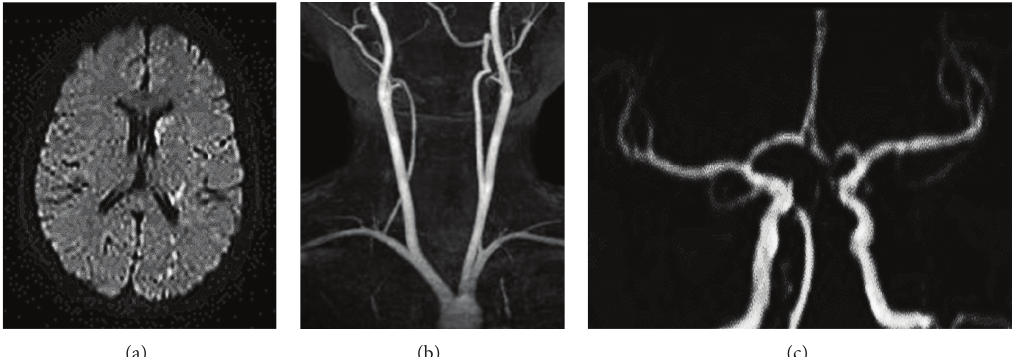
Figure 1: Brain MR images before cardiac tumor extraction. (a) Multiple hyperintense areas in the left basal ganglia, corona radiata, and cortex of the temporal lobe were found by diffusion-weighted MRI. (b) MR angiography did not reveal angiostenosis.